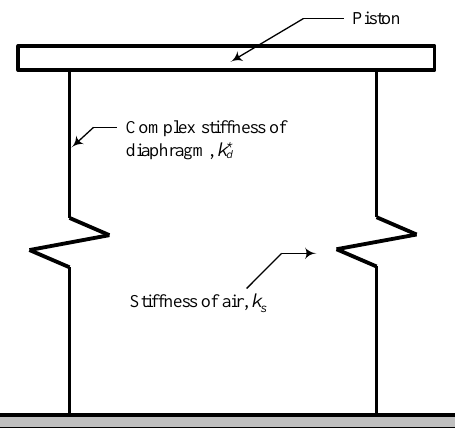
Figure 10. Equivalent mechanical model of the pneumatic spring.